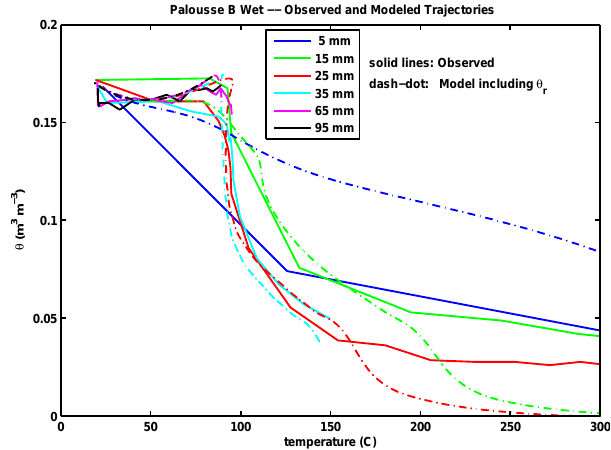
Figure 13. Observed and modeled soil moisture vs soil tempera- tures (trajectories) for the Wet Palousse B heating experiment. Solid lines are observed data and the dash-dot lines are from the model that includes the dynamic residual soil moisture, θ r .